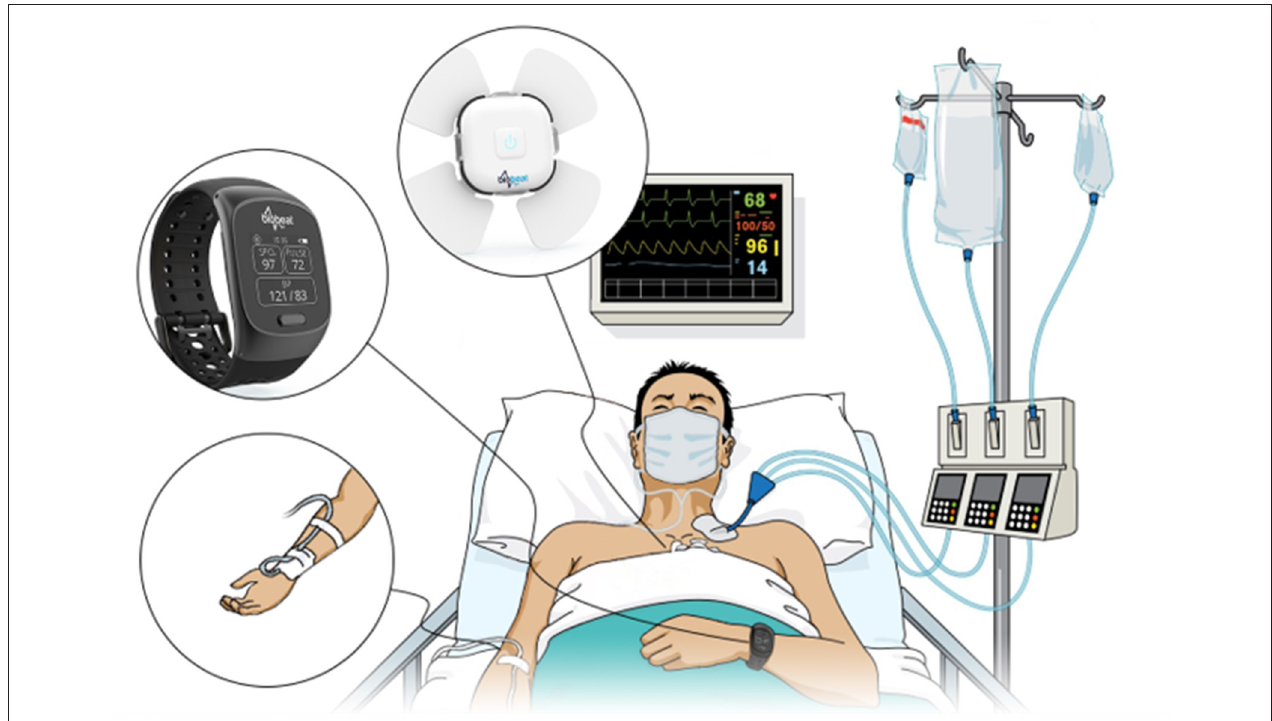
FIGURE 1 | An Arterial line and photoplethysmography-based wristwatch and chest-patch monitors were attached to each subject included in the